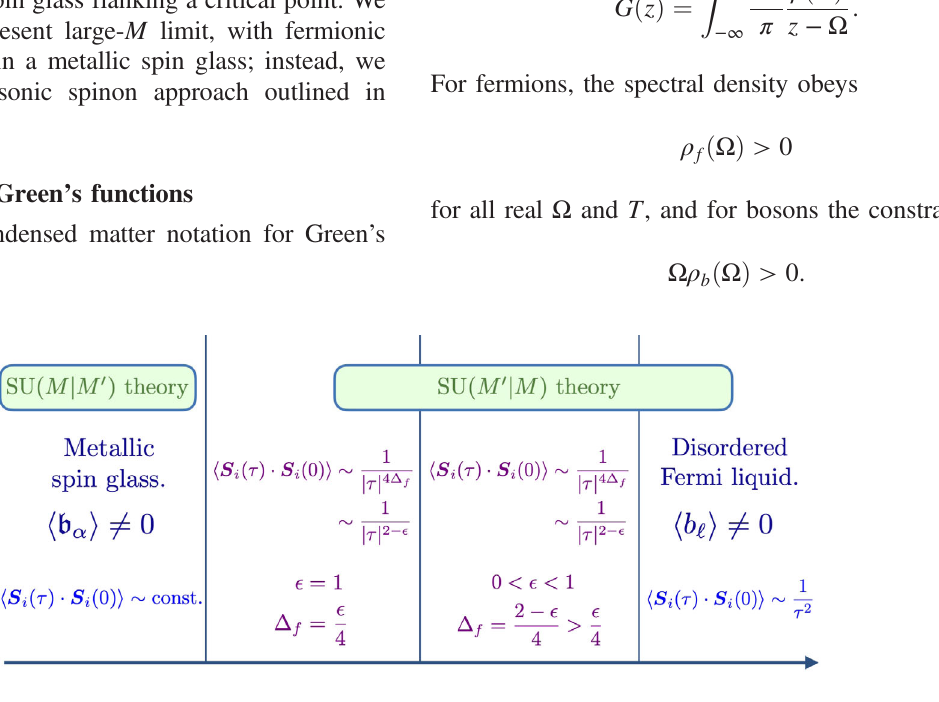
FIG. 8. Schematic phase diagram in the large- M limit, with the phases displaying more rapidly decaying spin correlations as we move to the right. This Appendix describes only the two intermediate critical phases in the SU ð M 0 j M Þ theory with bosonic holons and fermionic spinons. We propose in the present paper that, for the case M ¼ 2 and M 0 ¼ 1 , these two critical phases reduce to a critical point with the characteristics of the ϵ ¼ 1 phase, as shown in Fig. 1. A description of the spin-glass phase in the large- M limit requires fermionic holons and bosonic spinons in the SU( M j M 0 ) theory, which we do not examine here. We also note that, for M 0 > 1 , the disordered Fermi liquid phase also has glassy correlations associated with the orbital index l ¼ 1 … M 0